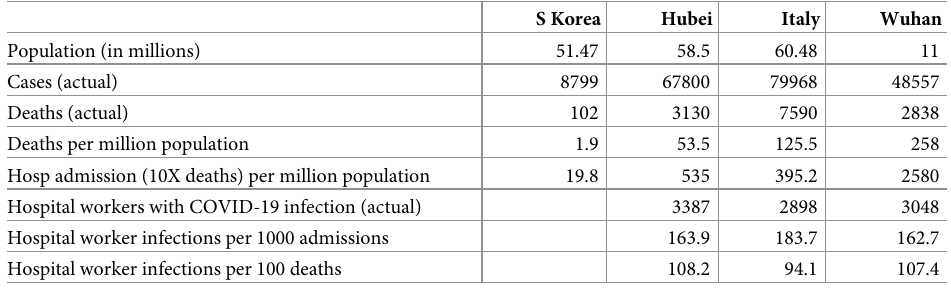
Table 1. Summary of the total cases and infections and deaths amongst hospital workers in Hubei province, China and